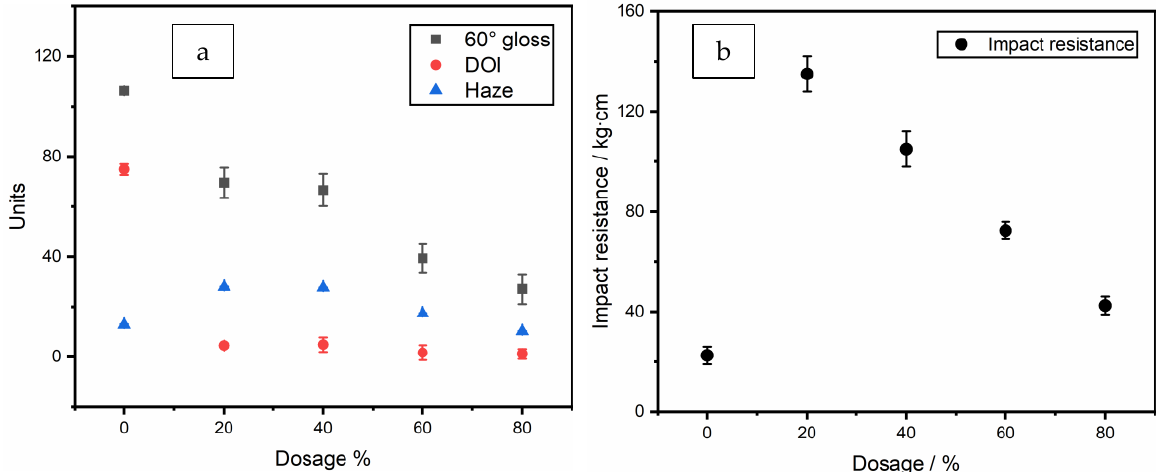
Figure 5. Surface quality ( a ) specular gloss, DOI and haze values; and ( b ) impact resistance of the coatings with 0–80% zinc.